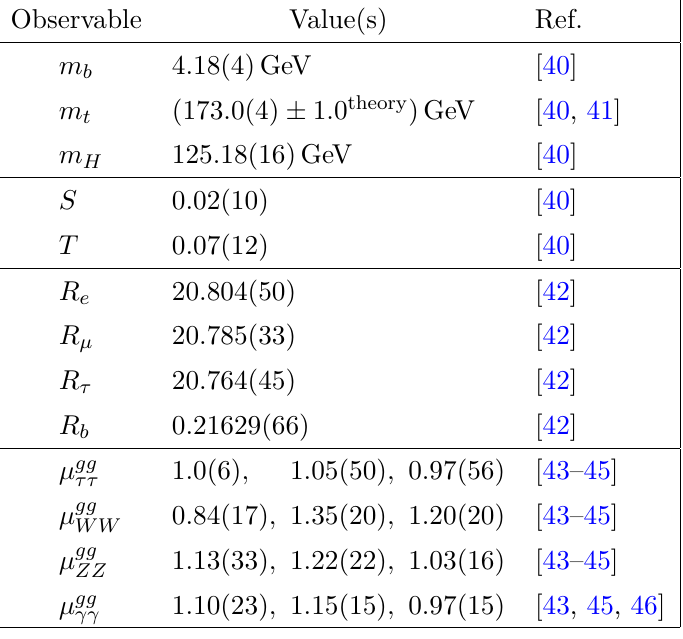
Table 4. Experimental values used for constraints in our scans. The observables are grouped (in order) into SM masses, oblique parameters, Z decay ratios, and Higgs signal strengths. The latter employ multiple independent measurements. Note the values for S and T have a correlation coefficient of +0 . 92 that is taken into account in the χ 2